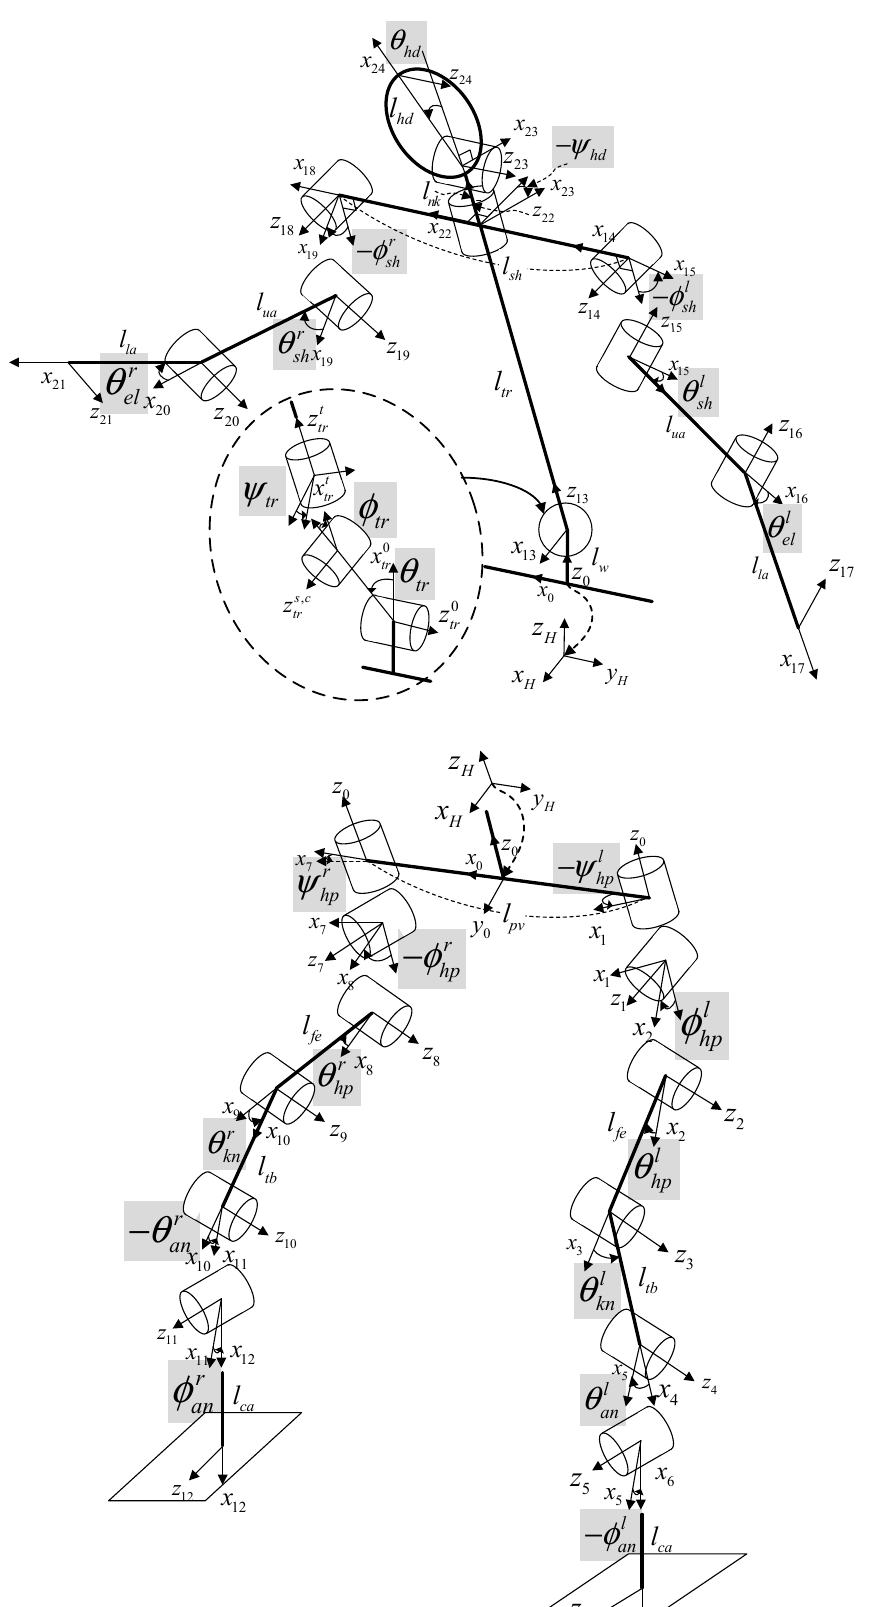
Figure 2. The 3D humanoid robot